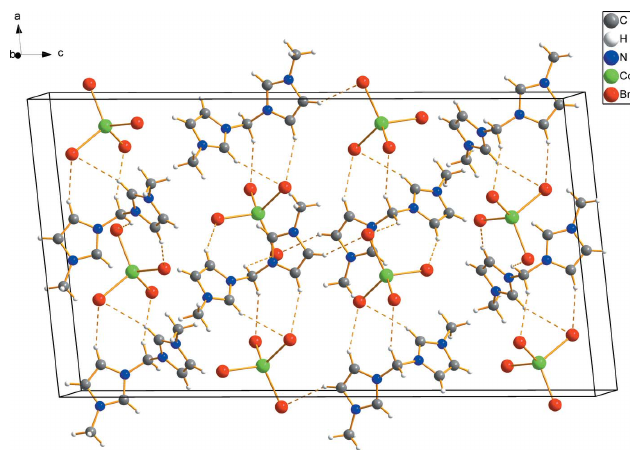
Figure 2 A packing diagram of the title compound viewed along the b axis, showing the C—H (cid:2)(cid:2)(cid:2) Br interactions (dashed lines).